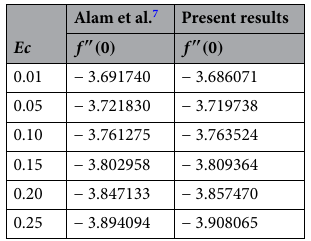
Table 2. Comparison of present results with Alam et al. 7 with Ri = 4 ; N = 0.5 ; R = 0.2 ; K = 0.5 ;